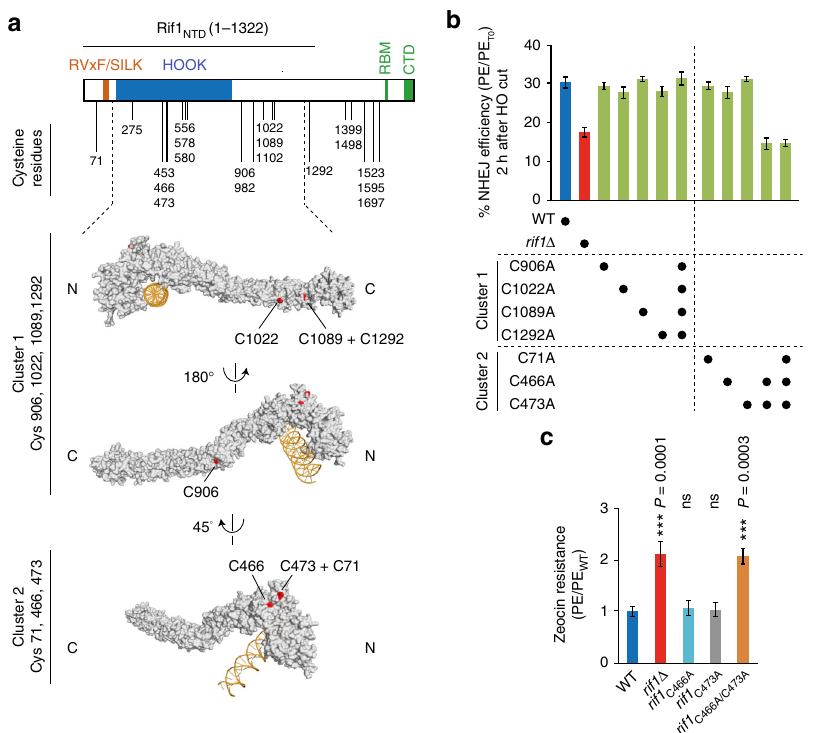
Fig. 2 C466 and C473 are required for Rif1-mediated NHEJ. a Top, Budding yeast Rif1 (1916 amino acid residues) contains four identi fi able functional domains: RVxF/SILK PP1-interacting domain; RBM and CTD Rap1-binding motifs; HOOK DNA-binding domain. The Rif1 N-terminal domain (Rif1 NTD , residues 1 – 1322) supports the protein ’ s function in NHEJ. The positions of cysteine residues, representing potential Rif1 S- acylation sites, are indicated. Bottom, surface representation of Rif1 (residues 177 – 1283) structure bound with DNA 3 , identifying surface-exposed cysteines. For mutational analyses, cysteines were grouped by proximity into clusters 1 and 2. C1292 and C71, for which structural data is not available, were included in cluster 1 and 2, respectively. b NHEJ ef fi ciency for Rif1 NTD cysteine clusters 1 and 2 mutants, determined as in Fig. 1b after 2 h of HO-endonuclease induction. Data are presented as mean values ± s.e.m. ( n = 3 independent experiments). c Viability of the indicated strains in the presence of Zeocin (70 μ g/ml). Data are presented as mean values ± s.e.m. ( n = 6 independent experiments). Statistical analysis was performed by one-way Anova and a post-hoc Tukey – Kramer multiple comparison test, comparing wild-type to the indicated mutants. PE, plating ef fi ciency; PE T0 , plating ef fi ciency without HO-endonuclease induction; PE RIF1 , plating ef fi ciency of RIF1 wild-type reference strain. See also Supplementary Fig. 2. Source data are provided as a Source Data fi cells expressing Rif1 NTD DNA-binding site mutant K437E/ K563E/K570E (referred to as HOOK mutant) 3 (Fig. 3a). Thus,